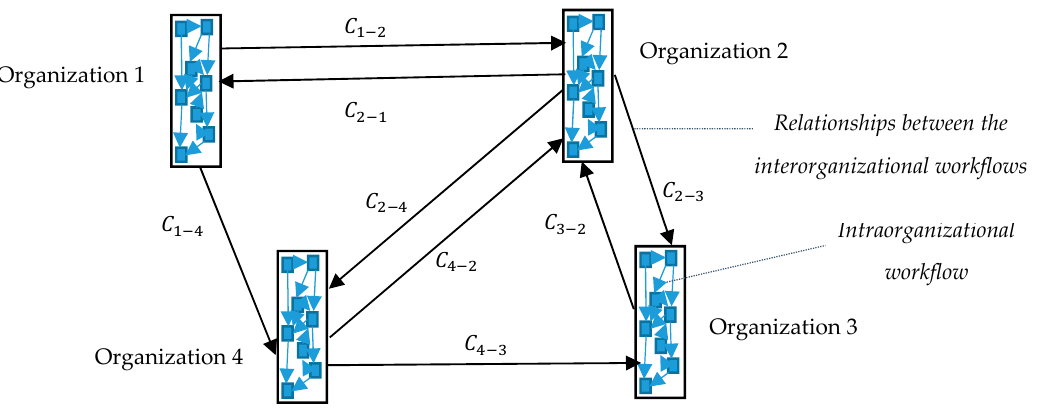
Figure 2. Role-based interorganizational workflow model.